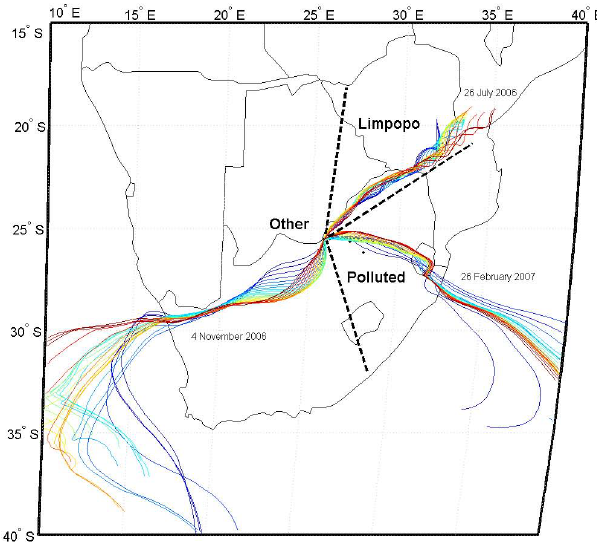
Fig. 3. Hourly 96-h HYSPLIT back trajectories arriving at the mea- surement site for three example days (24 trajectories for each day) demonstrating the area division used in our analysis. The colours of the trajectories (dark blue → light blue → yellow → red) indicate the hour when each trajectory arrives at Botsalano.